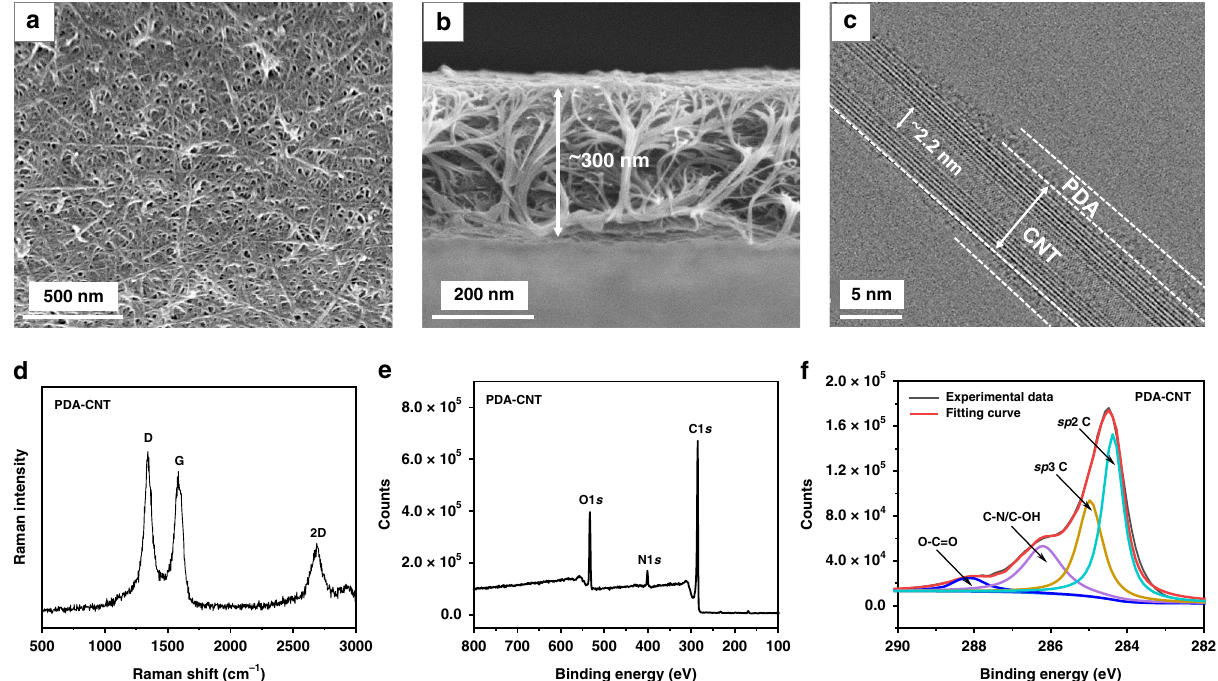
Fig. 1 Characterization of the PDA-CNT support. a Top-view SEM image. b Cross-section SEM image. c TEM image of a single CNT. d Raman spectra e XPS spectra of O, N, and C. f Deconvolution of the C1 s XPS peak.